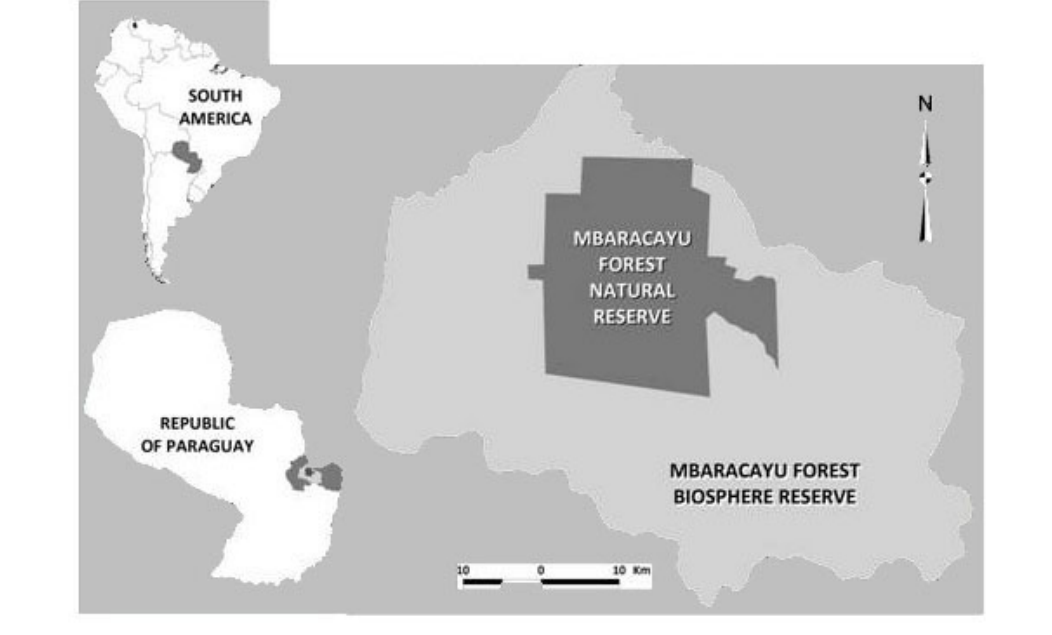
Fig. 1 . The location of the Mbaracayu Forest Biosphere Reserve and Natural